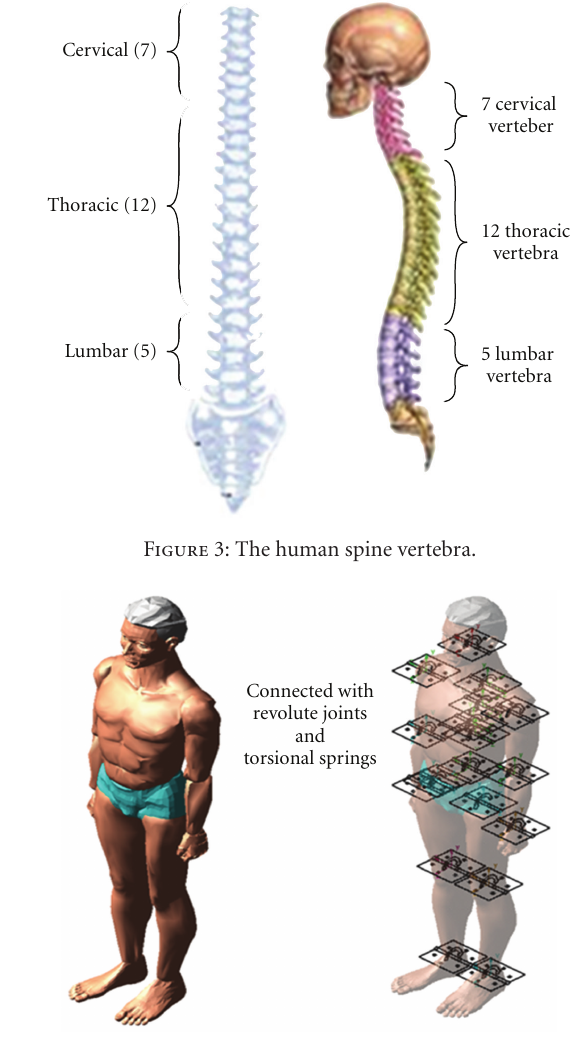
Figure 4: The combination of the human parts using revolute